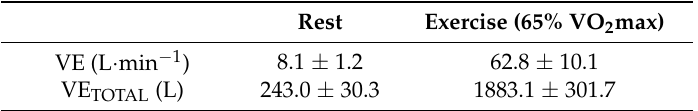
Table 1. Ventilation at rest and exercise ( n =